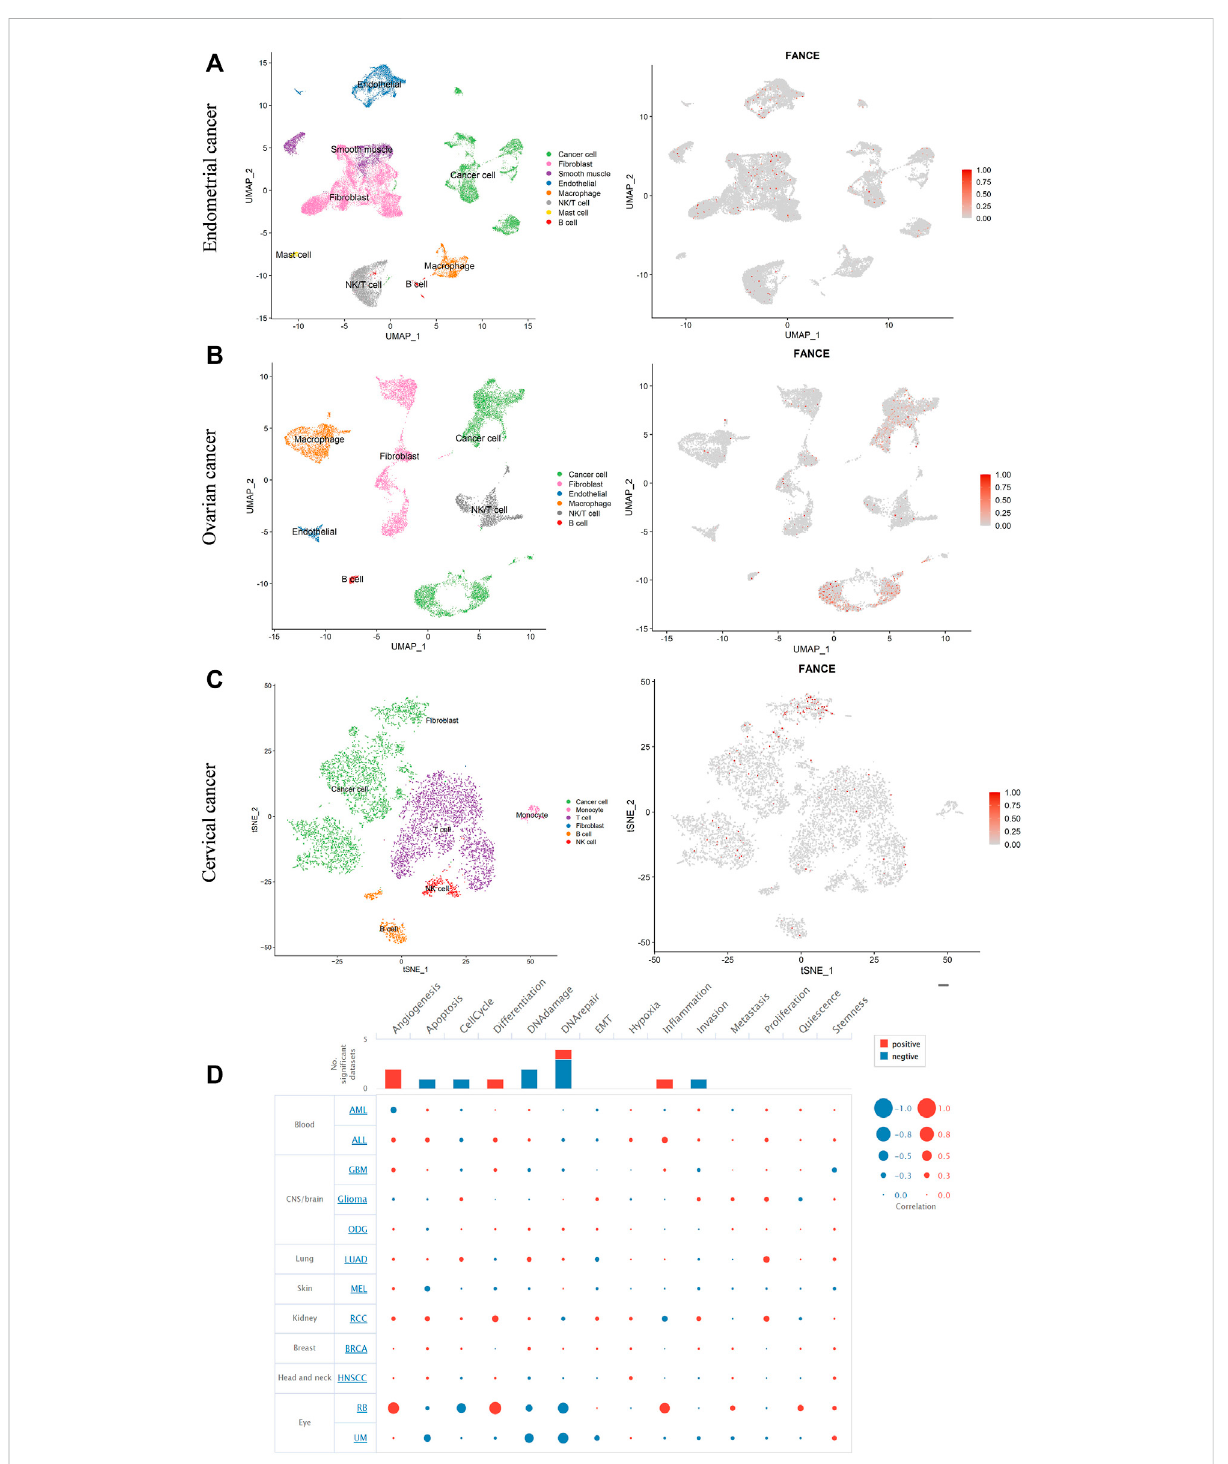
FIGURE 12 Single-cell RNA sequencing data analyze the expression of FANCE in different cells in endometrial cancer (A) , ovarian cancer (B) , and cervical cancer (C) based on the Gene Expression Omnibus (GEO) database. (D) The function of FANCE at the single cell level investigated by the cancer single-cell atlas (CancerSEA)